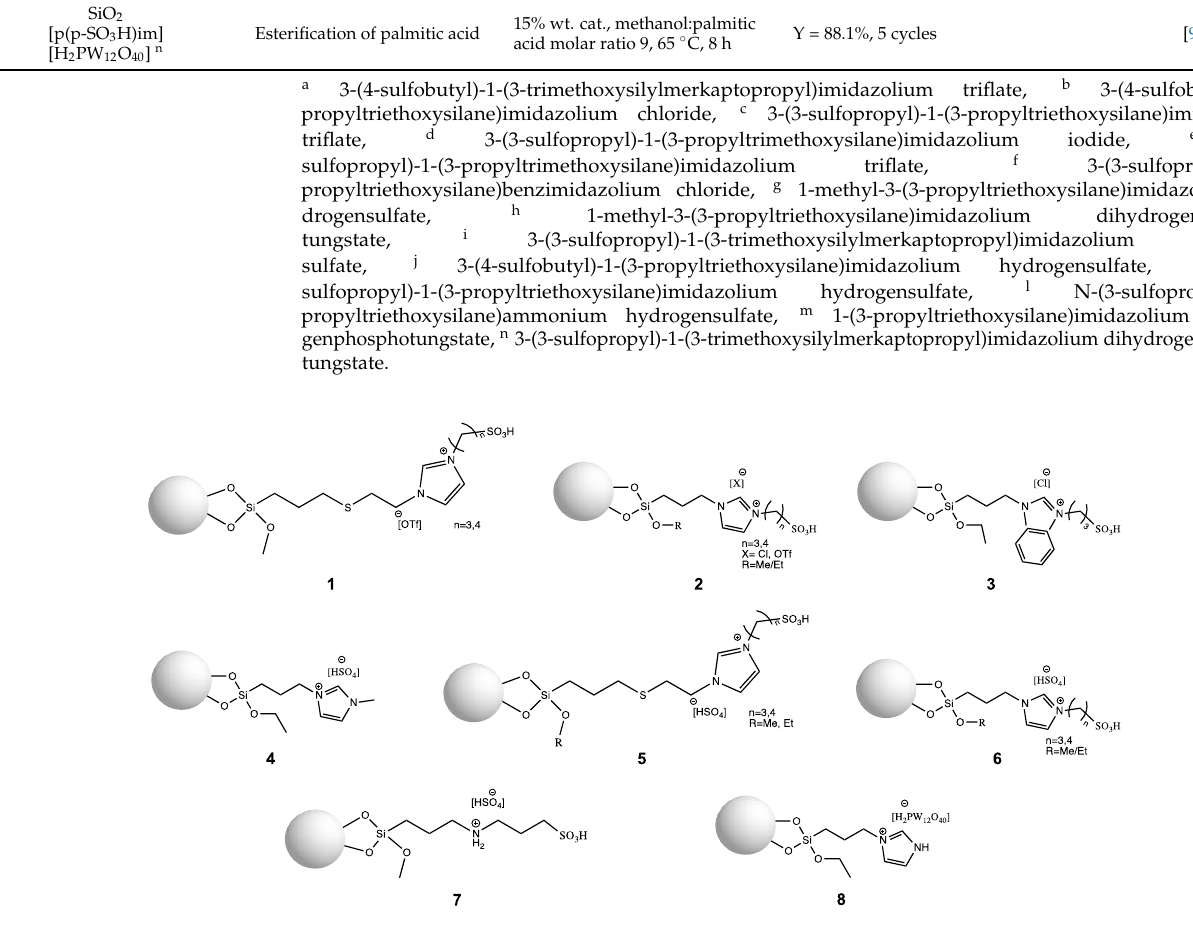
Figure 9. Structures of Brønsted-type silica-based SILLP materials. Table 2. Brønsted-type silica-based SILLP in organic catalysis.